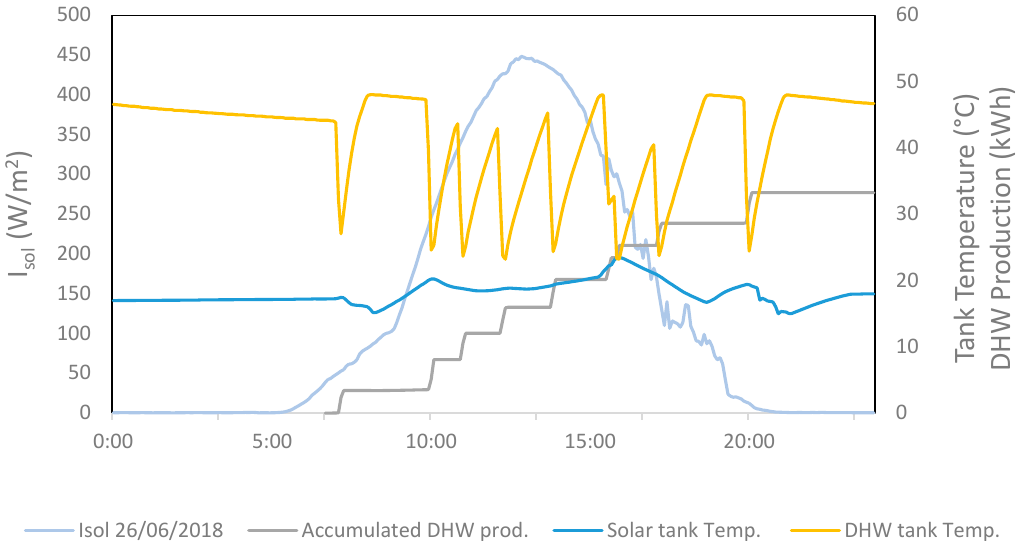
Figure 8. Temperature evolution in the solar storage tank and the DHW tank and accumulated DHW energy output in Day 2.